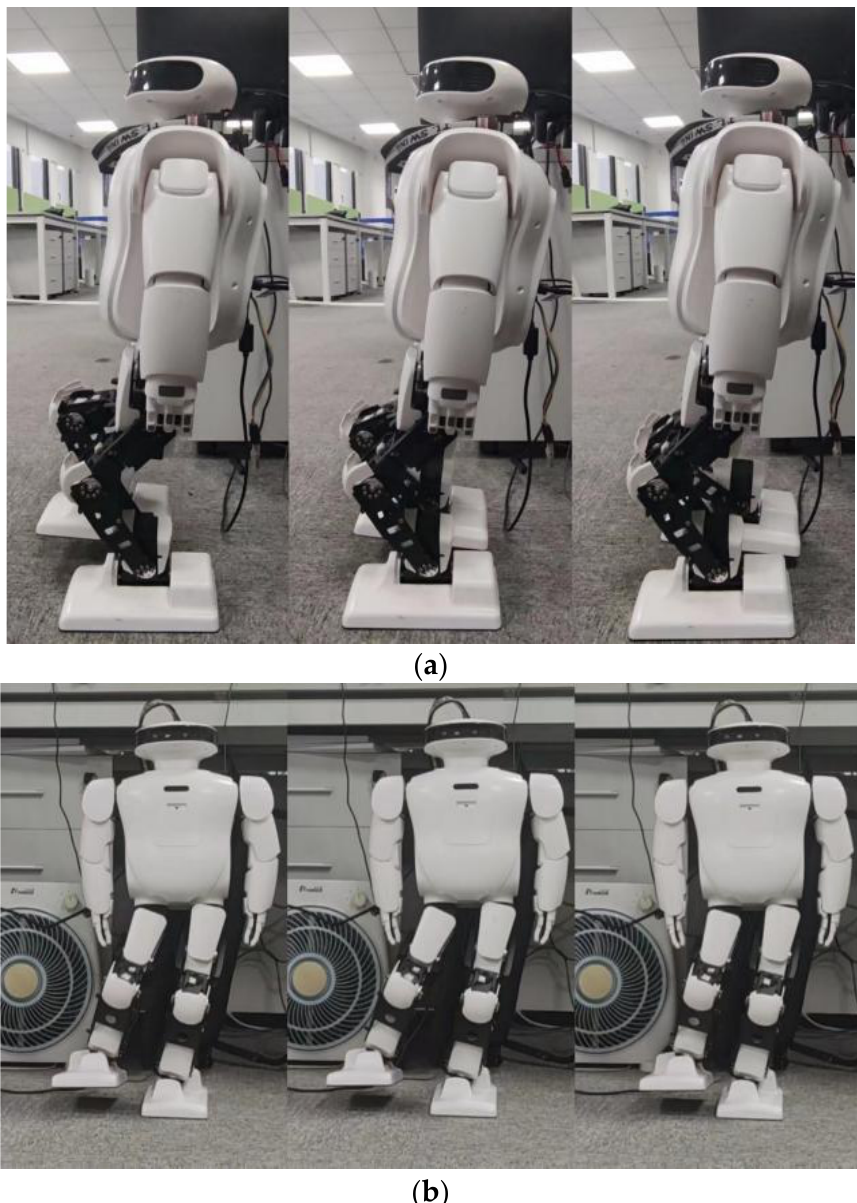
Figure 25. The Roban robot swings forward and sideways. ( a ) A side view of the robot swinging forward process. ( b ) A main view of the robot swinging sideways process.